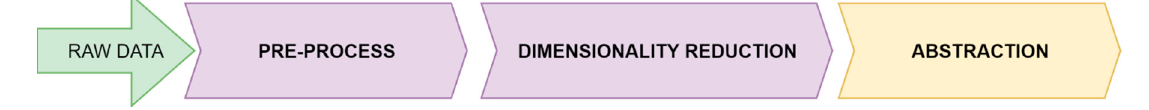
Figure 2. Data compression—abstraction process [4].